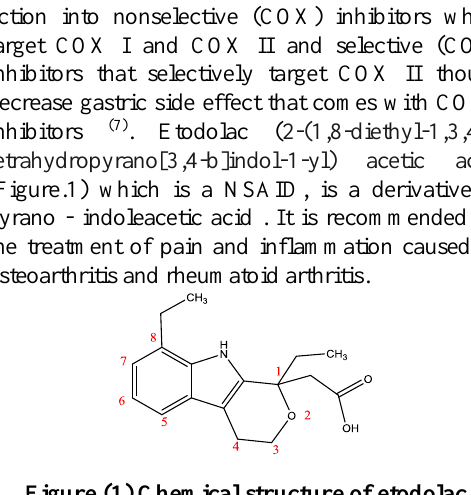
Figure (1) Chemical structure of etodolac The carboxylic acid group of NSAIDs can be replaced with other groups while these agents still exert a potent anti-inflammatory activity (8)